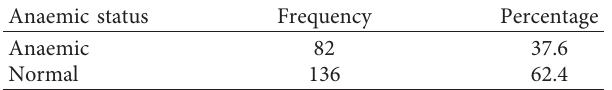
Table 2: Overall prevalence of anaemia in pregnancy.